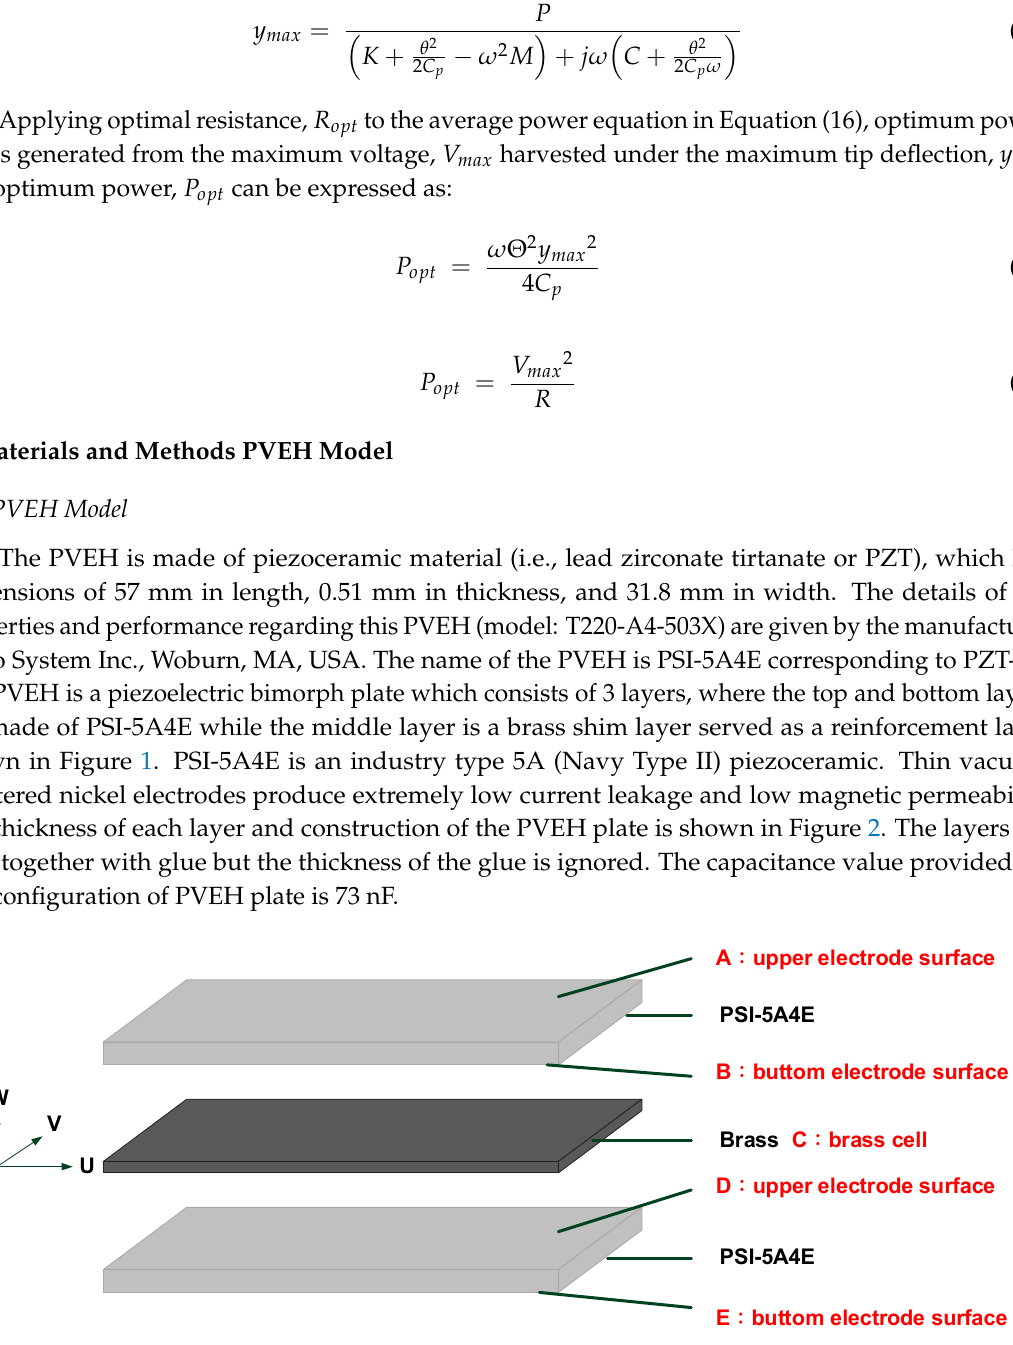
Figure 1. Construction and material properties of the piezoelectric vibration-based energy harvester (PVEH) plate.